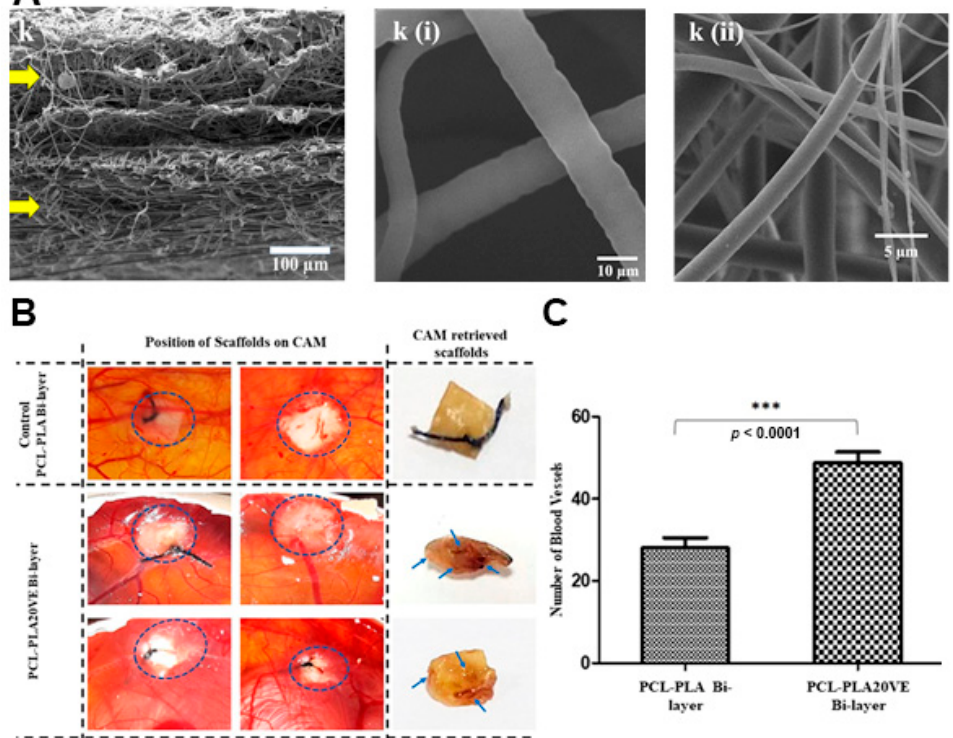
Figure 6. (A) SEM images of k) cross section of PCL-PLA20VE Bi-layer; k(i) PCL20VE; k(ii) PLA20VE. (B) Evaluation of angiogenic potential of the PCL/PLA asymmetric membranes with and without 20% of VE. The appearance and position of implanted membranes on CAM, at day 14 of fertilization, indicated by the circles. Blue arrows, on retrieved membranes, depict blood vessels infiltrated inside the explanted membrane. (C) Quantification of CAM assay by counting blood vessels around and inside the membranes, from the images taken at day 14, just before retrieving the membranes and sacrificing the eggs. The results are mean ± S.D. (*** p < 0.0001) of 4 viable chicks surviving from original group of 7 fertilized eggs per group. Reprinted with permission from [57], Elsevier, 2019. Otherwise, the asymmetric membranes can also be loaded with anti-inflammatory agents, such as curcumin, chrysin, ibuprofen, and pioglitazone (Pio) [14,54,90]. A chronic or uncontrolled acute inflammatory process could result in excessive production of inflammatory mediators, free radicals, and cytotoxic enzymes that could negatively impact on the healing process [85]. Yu et al. developed a poly( ε -caprolactone) (PeCL)/Gel nanofibrous asymmetric membrane loaded with Pio using a 40 μ m-pore-size nylon mesh template [54]. The hydrophobic PeCL layer was electrospun on the top side of the nylon mesh template, whereas the hydrophilic Gel-Pio blend was produced on the bottom side and crosslinked with genipin. The resulting membrane is composed of 270 nm diameter PeCL nanofibers on top and 144 nm Gel nanofibers in the bottom layer. The Pio release from the PeCL/Gel asymmetric membrane rapidly reaches 40% in day 1 and stabilizes around 75% until day